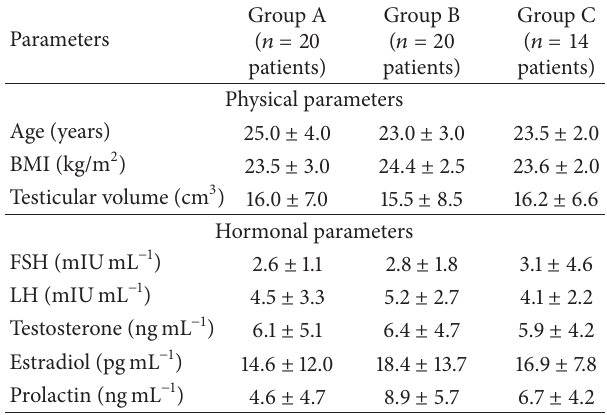
Table 1: Physical and hormonal characteristics at baseline of the three examined